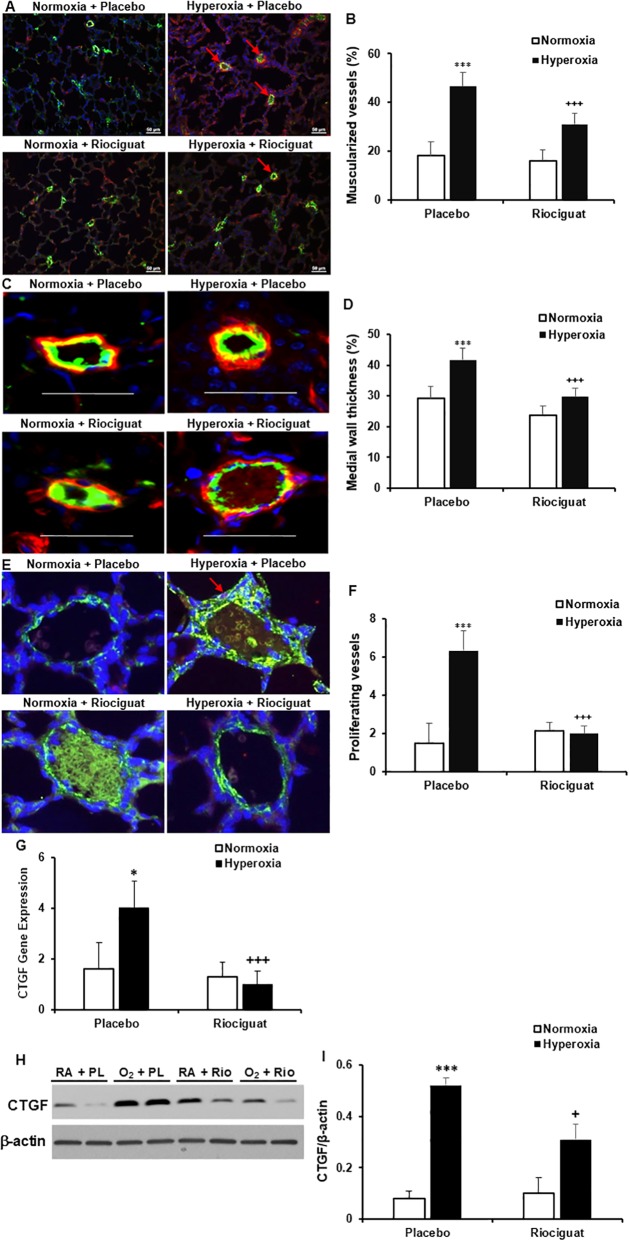
Riociguat decreases hyperoxia-induced vascular remodeling.(A, C) Double immunofluorescence staining for vWF (green signal) and α-SMA (red signal) plus DAPI nuclear stain (blue signal). (B) Hyperoxia exposure in the presence of placebo increased muscularization of peripheral pulmonary vessels (<50 μm in diameter) as compared with normoxia group (red arrow). Administration of riociguat decreased muscularized vessels in hyperoxia exposed lungs. (D) Hyperoxia increased medial wall thickness (MWT) in presence of placebo as compared with normoxia group. Riociguat administration significantly decreased MWT in hyperoxia group. ***P < 0.001 compared with normoxia; +++P < 0.001 compared with hyperoxia + placebo (n = 6/group). Scale bar: 50 μm. (E) Double immunofluorescence staining with Ki67 (red arrow) and α-SMA (green signal) plus DAPI nuclear staining (blue signal). (F) Hyperoxia exposure in the presence of placebo increased vascular proliferation as compared with normoxia group. Administration of riociguat decreased vascular proliferation. ***P < 0.001 compared with normoxia; +++P < 0.001 compared with hyperoxia + placebo (n = 6/group). (G) CTGF gene expression was up-regulated by hyperoxia and it was down-regulated by riociguat. *P < 0.05 compared with normoxia; +++P < 0.001 compared with hyperoxia + placebo (n = 6/group). (H) Representative Western blots of CTGF and β-actin. (I). Expression of CTGF was increased by hyperoxia, while administration of riociguat decreased CTGF expression in hyperoxia exposed lungs. ***P < 0.001 compared with normoxia; +P < 0.05 compared with hyperoxia + placebo (n = 6/group). RA: room air, normaxia; O2: hyperoxia; PL: placebo; Rio: riociguat.